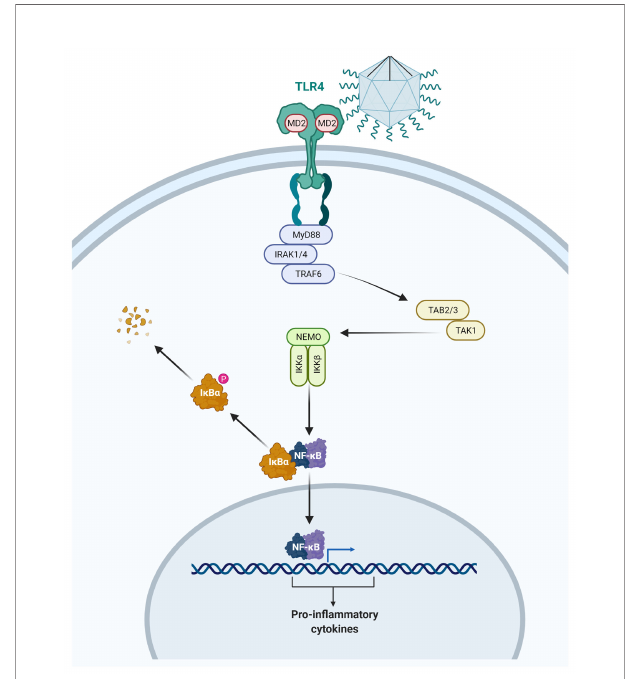
FIGURE 4 | Illustration representing the activation of the myeloid 88 dependent TLR4 pathway by contact with the APMV. Following the TLR4 activation, the IRAK4 kinase suffers phosphorylation and activates IRAK1 resulting in TRAF6 recruitment. This allows the TAK1 and TAB2/3 complex to activate the kinases IKK a , IKK b , and IKK g . These enzymes promote the IkB phosphorylation and its degradation allows the translocation of the nuclear factor-kB (NF-kB) to the nucleus, and the production of in fl ammatory cytokine. This representation is merely illustrative and is not up to scale. Drawing created with